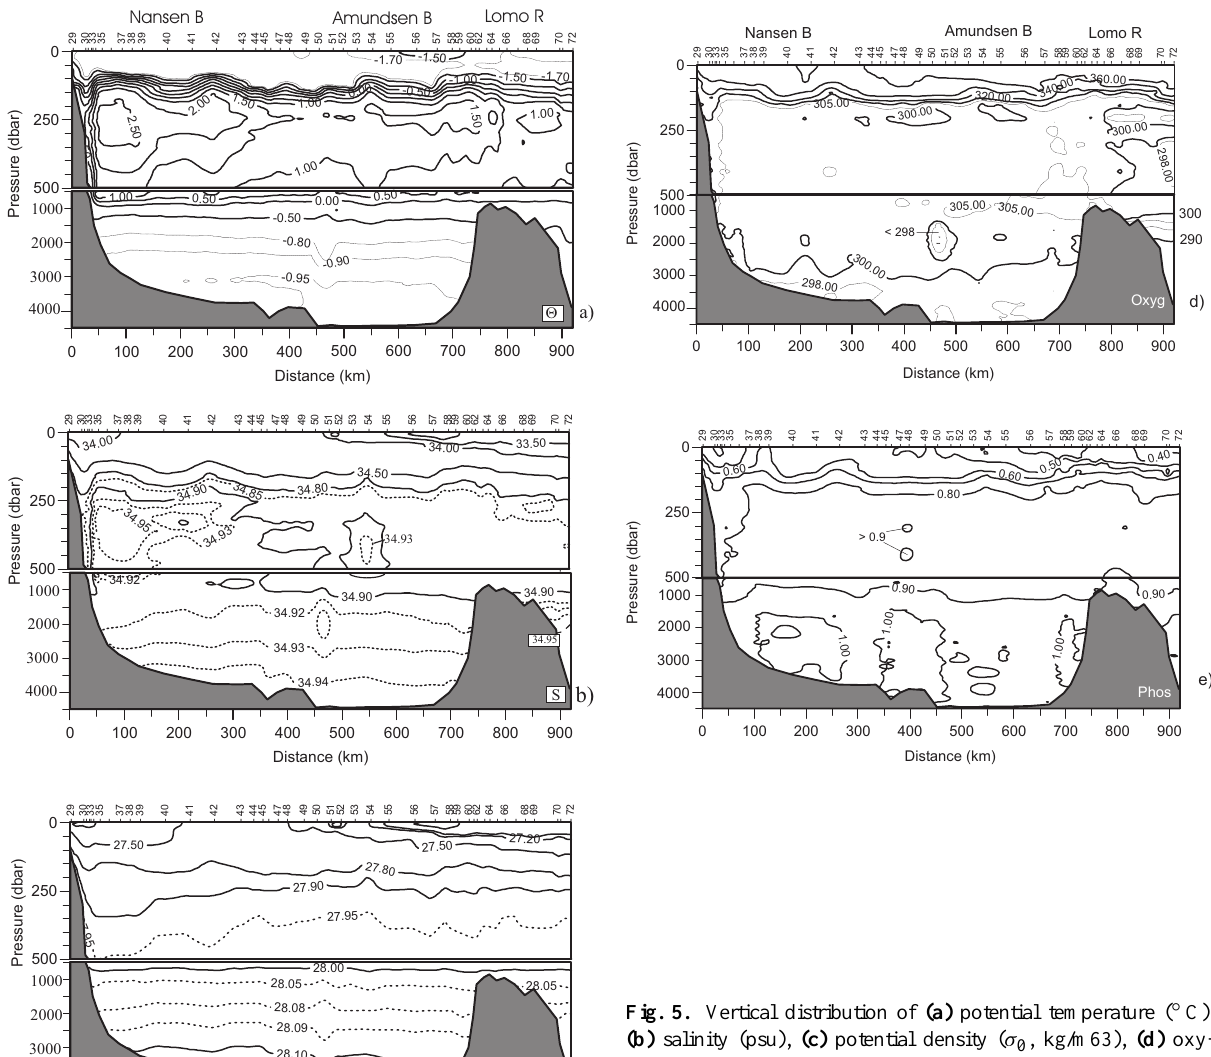
Fig. 5. Vertical distribution of (a) potential temperature ( ◦ C), (b) salinity (psu), (c) potential density ( σ 0 , kg/m63), (d) oxy- gen ( µ mol/kg), and (e) phosphate ( µ mol/l) across the Nansen, Amundsen and into the Makarov